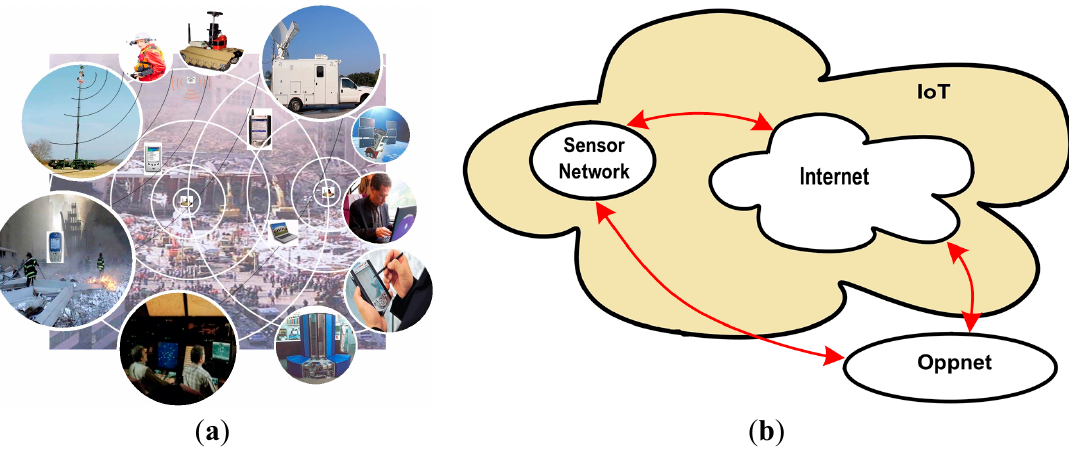
Figure 7. ( a ) Heterogeneous connectivity scenario; ( b ) Communication